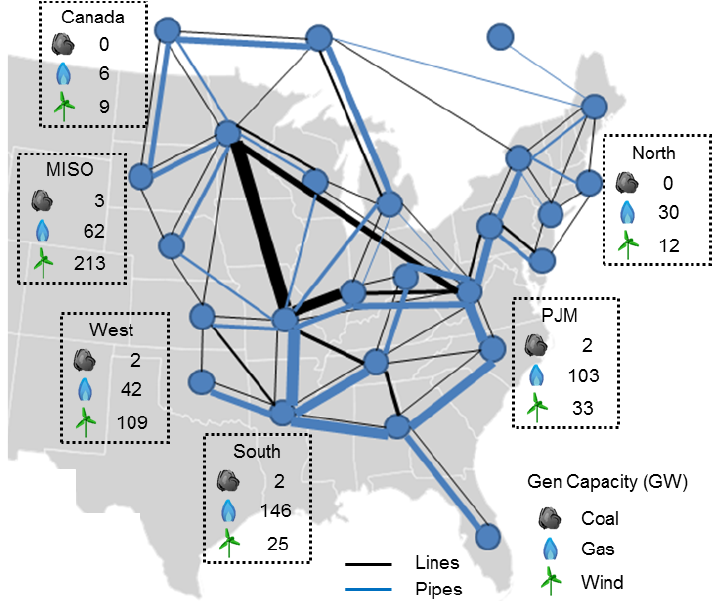
Figure 2. Integrated gas-electric network. Table 2. Transportation initial capacity and